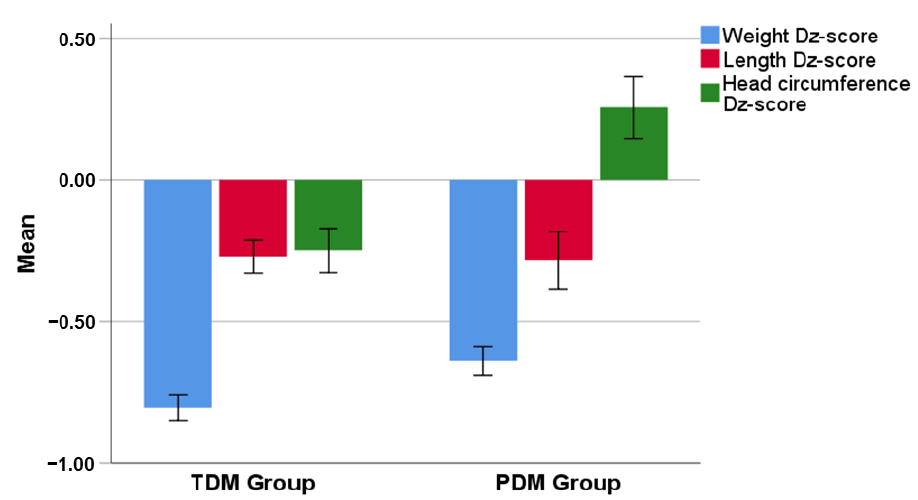
Figure 2. ∆ z-scores for body weight ( p = 0.019), body length ( p = 0.720) and head circumference ( p = 0.001) from birth to the end of intervention (donor milk period) between preterm (PDM) and term donor milk (TDM) Group.